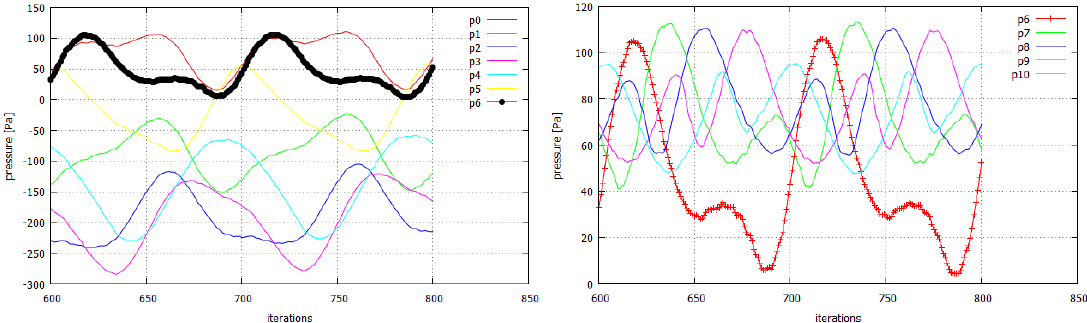
Figure 11: Pressure evolution for case E2 along the diaphragm at points p0,...p6 (left) and p6,...p10 (right).